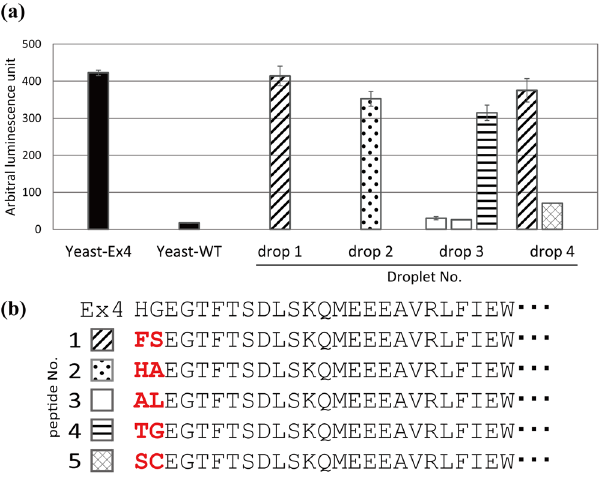
Figure 5. Functional evaluation of yeast cells producing randomized Exendin-4 (Ex4) variants isolated by high-throughput functional cell-based assay using droplet microfluidics. ( a ) Evaluation of the activity of the randomized Ex4 variants secreted by isolated yeast cells. The adherent hGLP1R/NLuc-293 cells were incubated with culture supernatants of the isolated yeast cells, and luminescence intensity was quantified. Yeast-Ex4 and Yeast-WT were used as a positive control and a negative control, respectively. Values were given as mean ± SD (n = 3). ( b ) Sequences of the isolated Ex4 variants. Amino acids shown in red indicate the N-terminal two amino